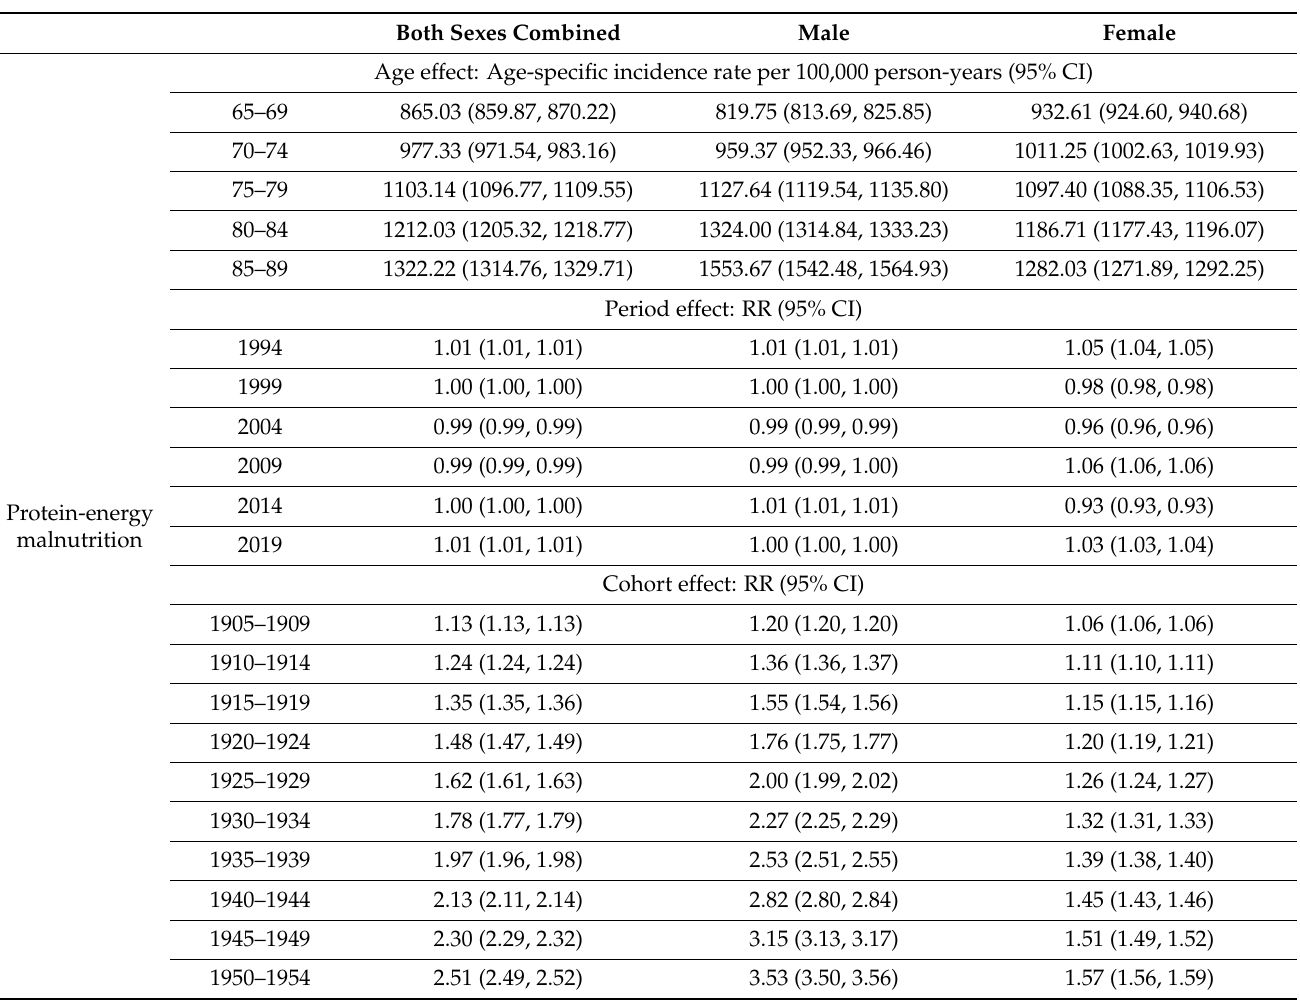
Table 1. Cont. Both Sexes Combined Male Female